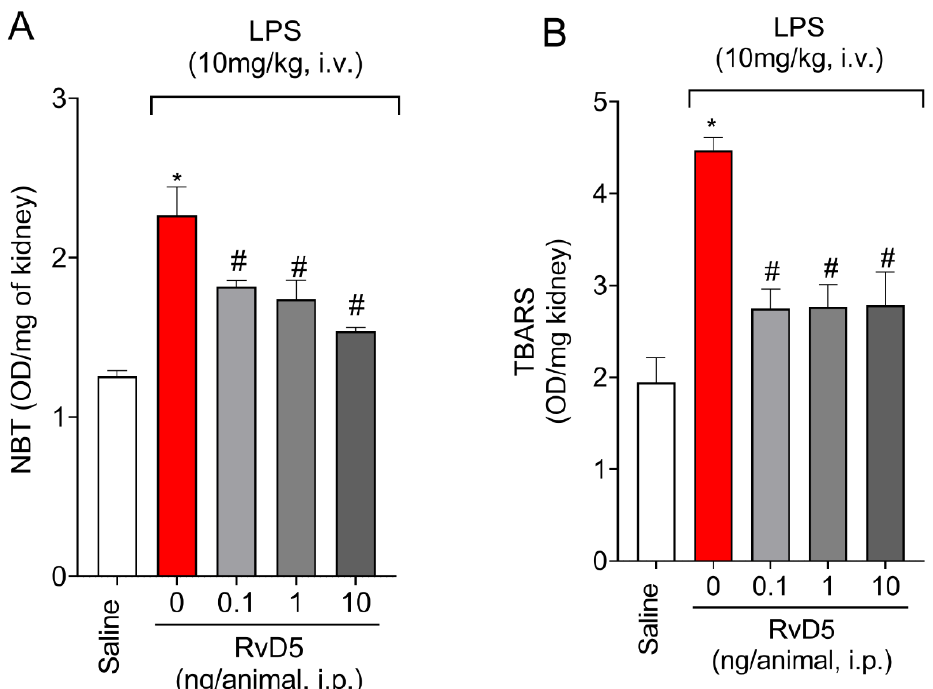
Figure 5. RvD5 reduces superoxide anion production and lipid peroxidation levels in the kidneys. Superoxide anion production by the NBT method ( A ) and lipid peroxidation by the TBARS method ( B ) were quantitated in the kidneys. Results are presented as standard ± SEM (standard error mean) of six animals per group and are representative of two replicates. (* p < 0.05 vs. saline, # p < 0.05 vs. LPS 10 mg/kg; one-way ANOVA followed by Tukey’s post-test).